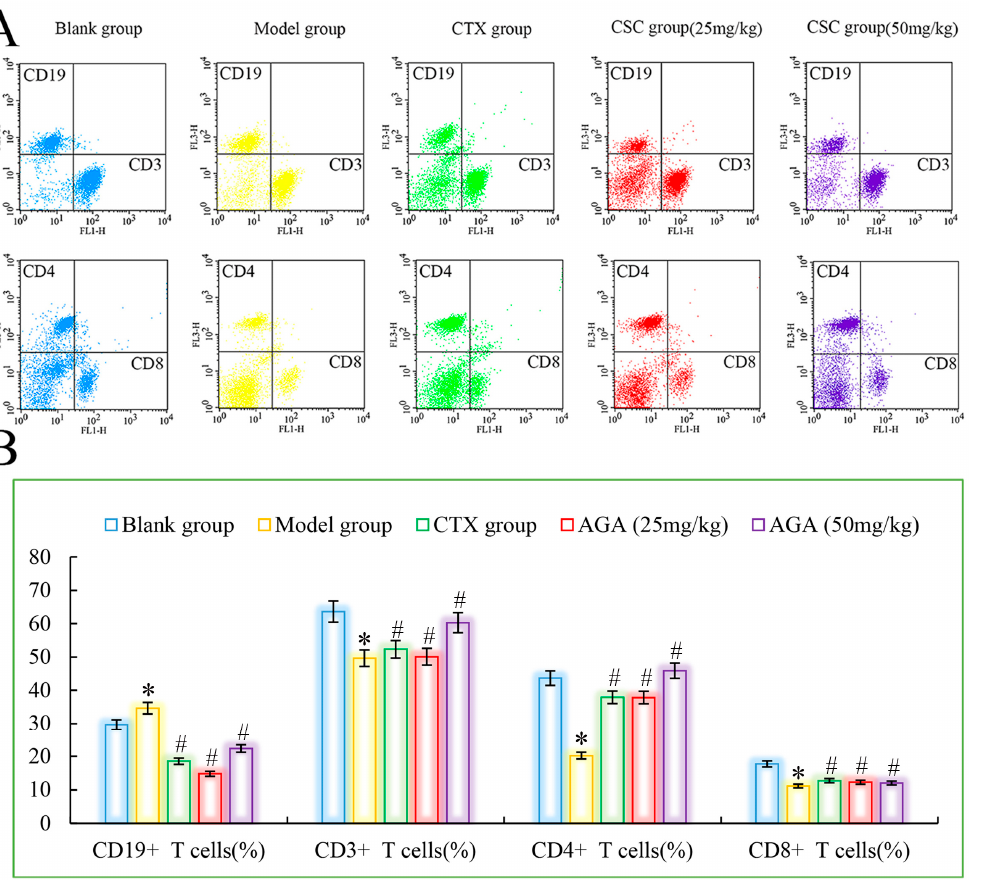
Figure 5. The distribution ( A ) and proportions ( B ) of lymphocytes subsets in peripheral blood. * p < * p < 0.05, compared with Blank group; # p < 0.05, compared with Model 0.05, compared with Blank group; # p < 0.05, compared with Model group.